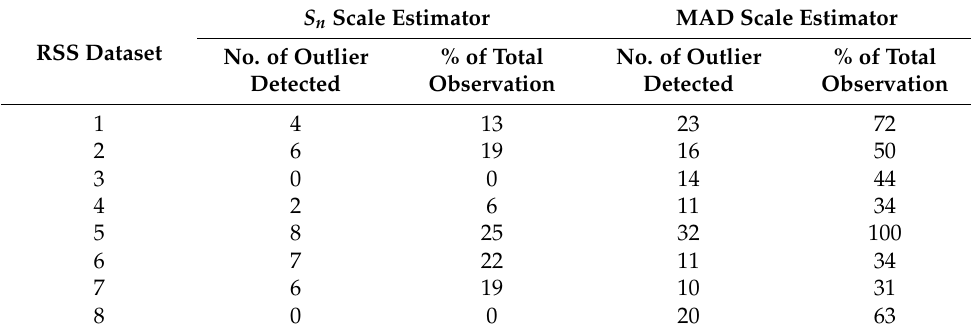
Table 2. Comparison of the number of detected outliers.